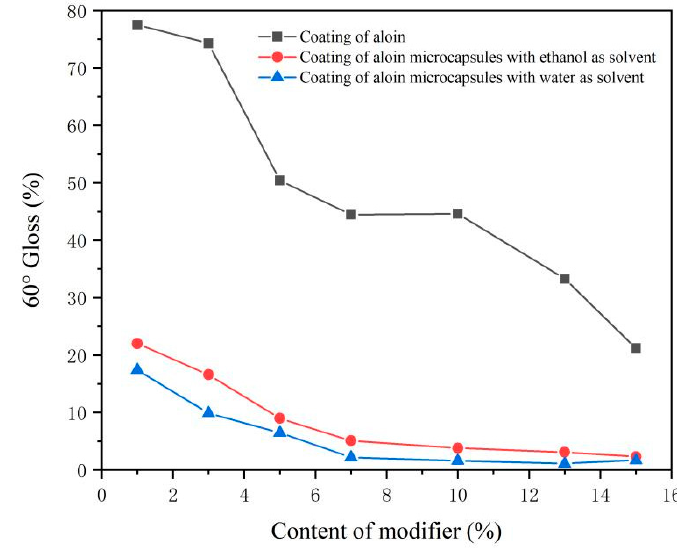
Figure 5. Surface gloss of coating with different content of modifier.